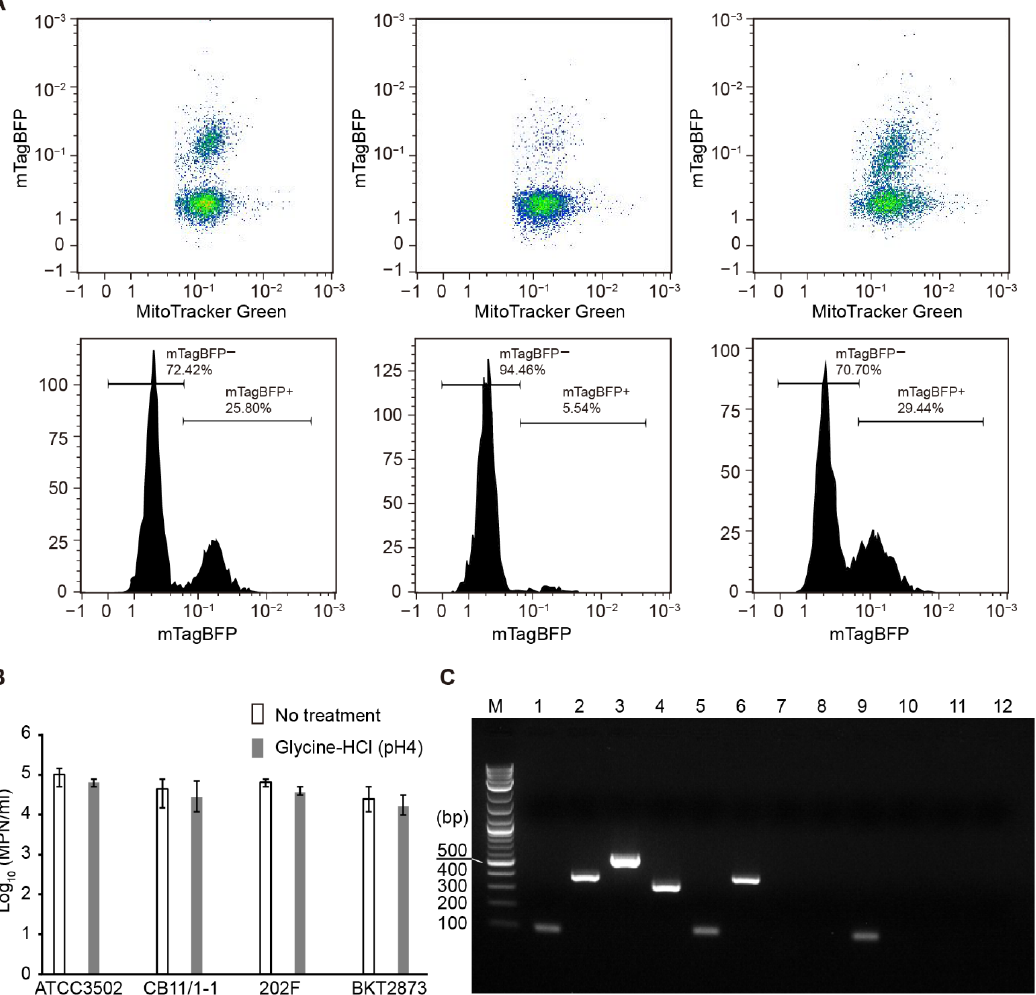
Figure 3. mTagBFP-CBD-based flow cytometry separation of Clostridium botulinum ATCC3502 and ATCC19397 from C. botulinum CB11/1-1, 202F, and BKT2873 strains. ( A ) Representative cytometric plots of the cell pools containing ATCC19397 with no treatment (left panel), and the cell pools containing ATCC3502 cells non-treated (middle panel) or treated (right panel) with 0.2 M glycine-HCl (pH 4) for 1 min. Gating of the subpopulations with a high intensity for mTagBFP (mTagBFP+) is indicated in the corresponding histograms. ( B ) Most probable number (MPN) enumeration of equal fractions of each C. botulinum ATCC3502, CB11/1-1, 202F, and BKT2873 strains that were treated or not treated with 0.2 M glycine-HCl (pH 4) for 1 min. The results are presented as the means of three replicates ± standard deviations. ( C ) Representative gel image of PCR products of the cell pool before sorting (lanes 1–4), and MPN dilution series (lanes 5–8, the first ten-fold dilution; lanes 9–12, the second ten-fold dilution) of the sorted cell populations of mTagBFP+. Lane M, 1 kb plus DNA ladder; lanes 1, 5, and 9, PCR products of bont/A (101 bp); lanes 2, 6, and 10, PCR products of bont/E (389 bp); lanes 3, 7, and 11, PCR products of bont/F (543 bp); lanes 4, 8, and 12, PCR products of bont/CD (327